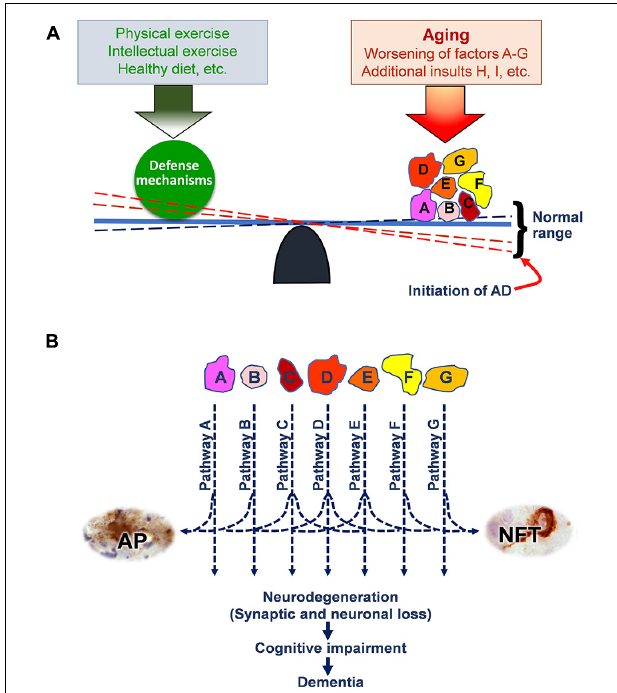
FIGURE 1 | The multifactorial hypothesis of AD. (A) The balance between the potential factors/insults accumulated during normal aging and the defense mechanisms. Worsening of these factors/insults (such as A to G) and/or adding of additional insults (such as H, I, etc.) can initiate the onset of AD. Factors/insults A to G represent genetic risk factors and those insults that accumulate during aging, such as mutations in presenilin and APP genes, ApoE4, amyloid β accumulation, oxidative stress, neuroinflammation, etc. Factors/insults H and I represent additional pathological insults, such as brain insulin resistance, repeated traumatic brain injury, and environmental insults. (B) The multifactorial insults collectively cause neurodegeneration through multiple molecular mechanisms/pathways and consequently cognitive impairment and dementia. Some of these pathways also lead to the formation of amyloid plaques (APs) and neurofibrillary tangles (NFTs), which are part of the end products of these pathways and are also hallmark brain lesions of AD. Reproduced with permission from Gong et al. (2018), which is available at IOS Press through http://dx.doi.org/10.3233/JAD-179921. The reproduction permission was obtained from IOS